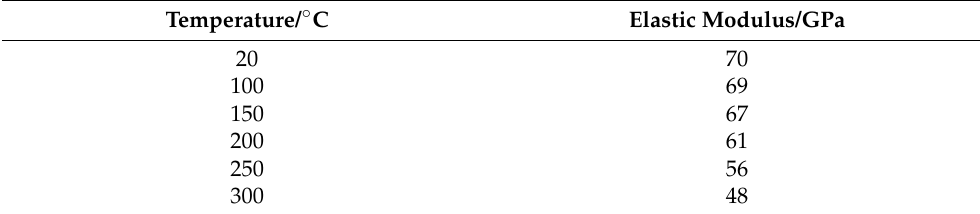
Table 9. The real elastic modulus with temperature-dependent.